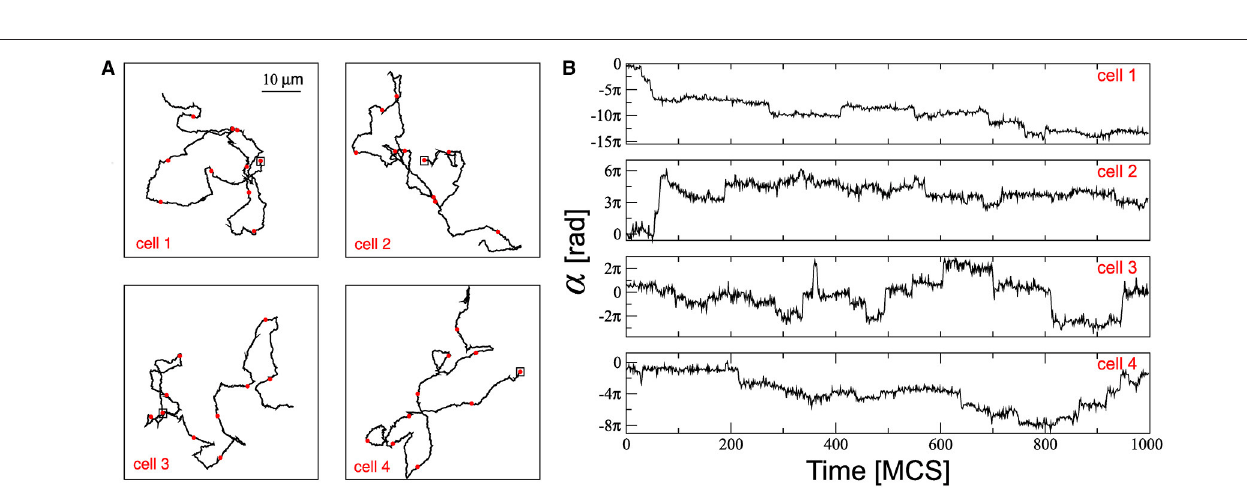
FIGURE 1 | Typical snapshots of a simulation carried out on a lattice of 512 × 512 sites at two different times: (A) initial time ( t = 0) in which the dynamic starts with the presence of driving forces acting on each cell, (B) after t = 2,000 MCS the cells have moved on the medium. For example, gray colored cell has displaced across scales much larger than the cell size. The parameter values used for this simulation were ρ = 0.2, τ = 10 MCS, and φ = 0.95.